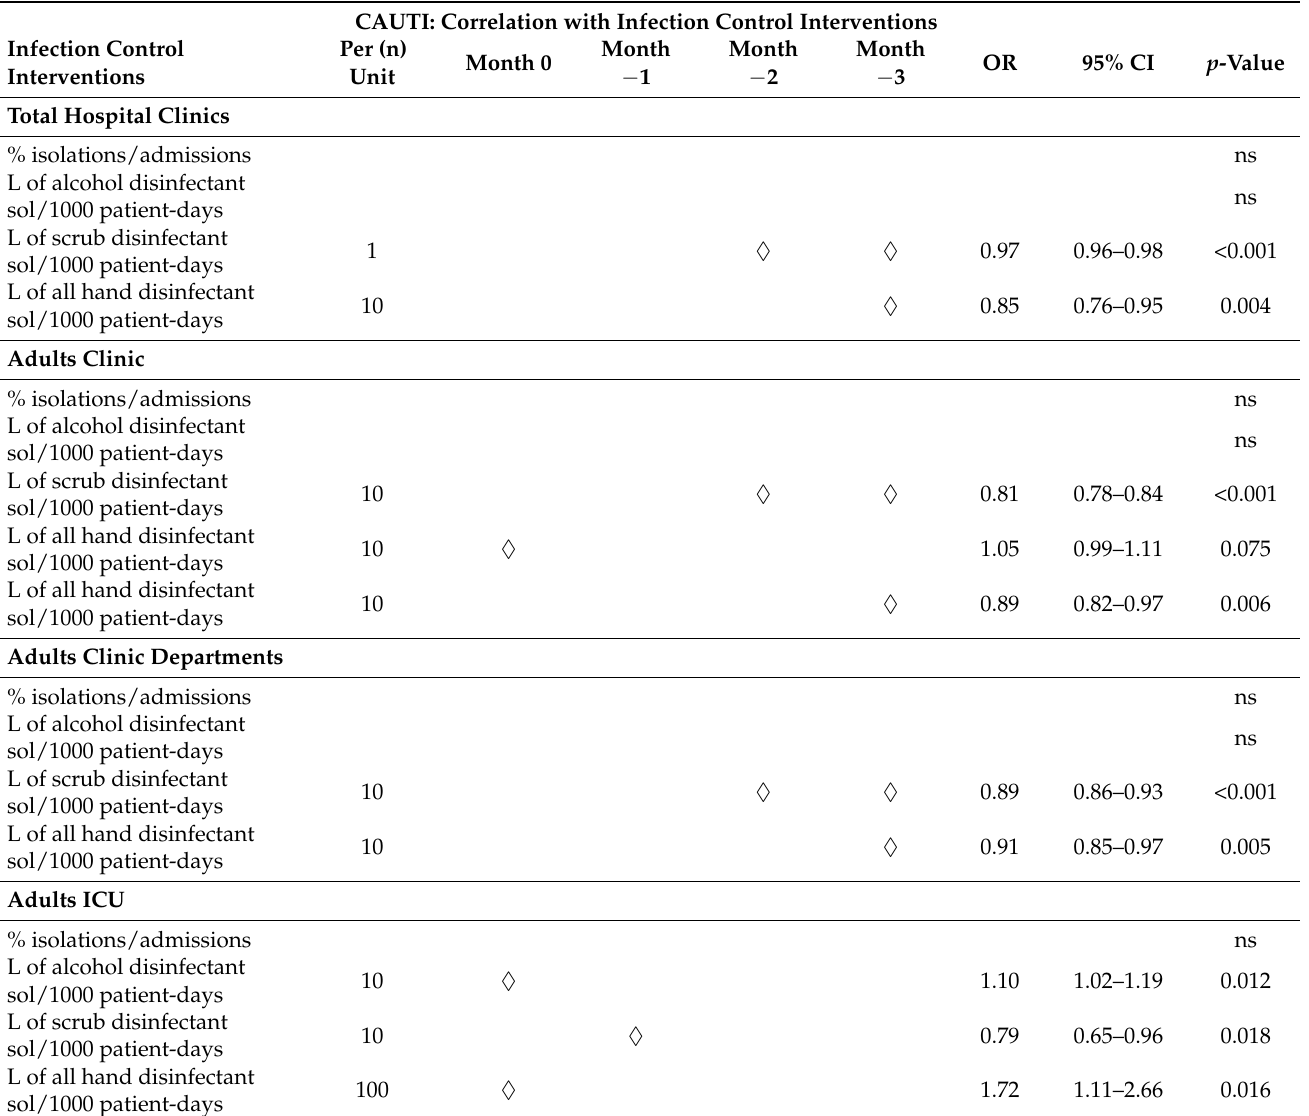
Table 6. Correlation of CAUTI and infection control interventions in a hospital from January 2013 to December 2018. CAUTI: Correlation with Infection Control